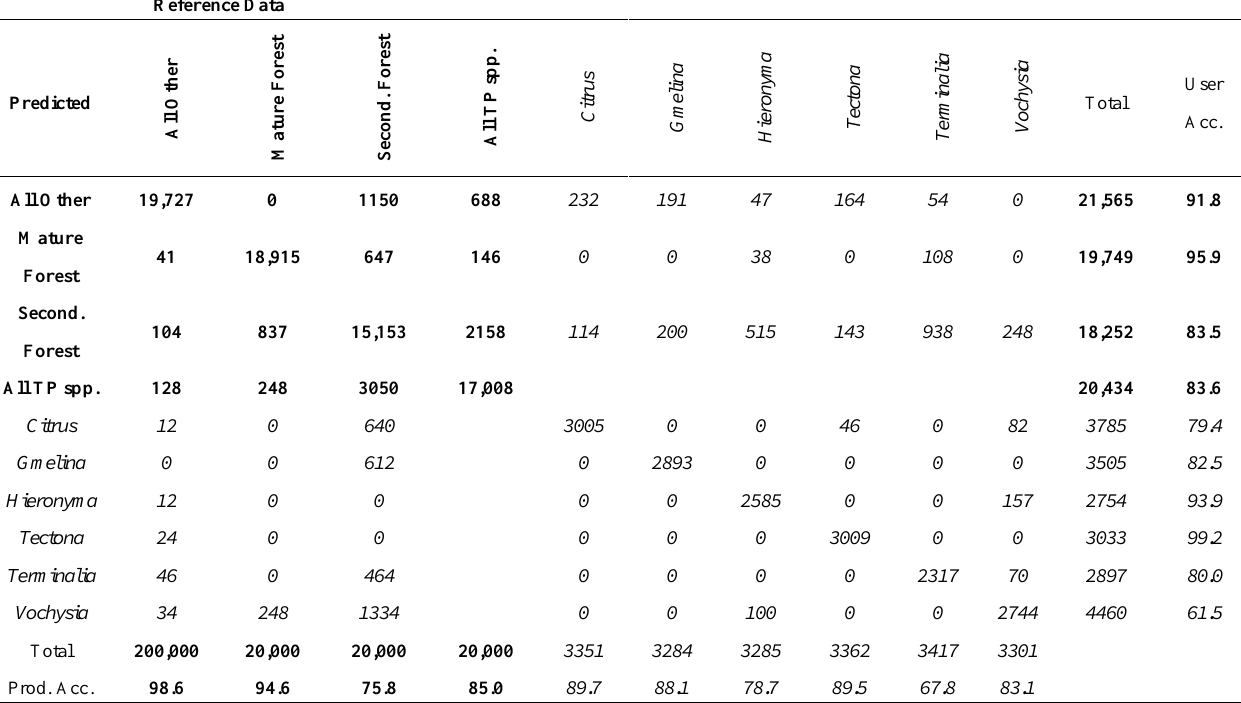
Table 5. Full confusion matrix for the HyperLsLS Random Forest model, with tree plantations as a class separated into the component tree species. The confusion matrix in bold is same one shown in Table 4. Row and column totals and accuracies in bold refer to the confusion matrix in bold. The individual tree species (italics) sum up to the all tree plantation species category in bold to the top left. We show mean user’s and producer’s accuracy for the filtered final map from 1000 subsampled runs with 20 samples each (20,000 samples